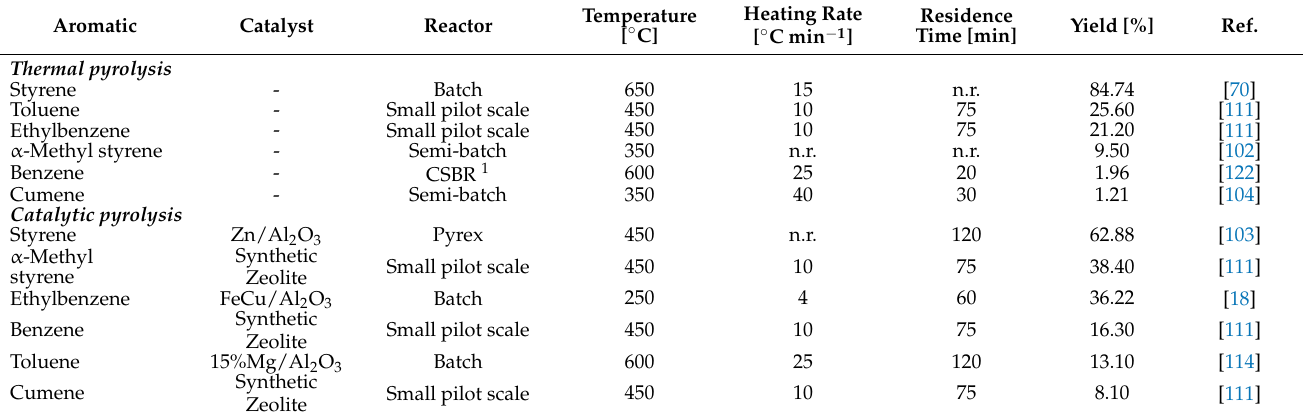
Table 2. Summary of production of aromatic hydrocarbons from PS thermo-catalytic